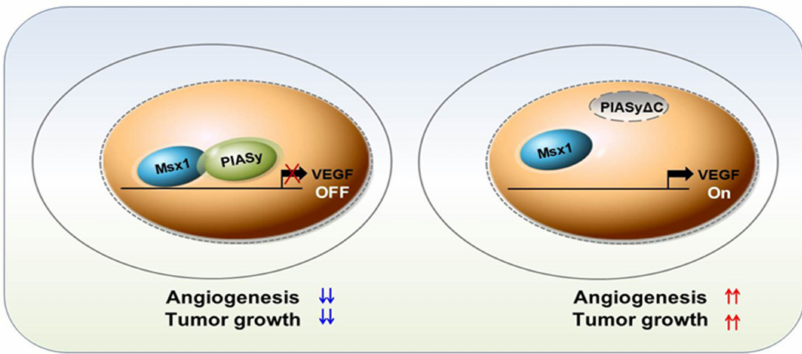
Figure 6. Diagram of proposed Msx1-PIASy-mediated angiogenesis suppression.